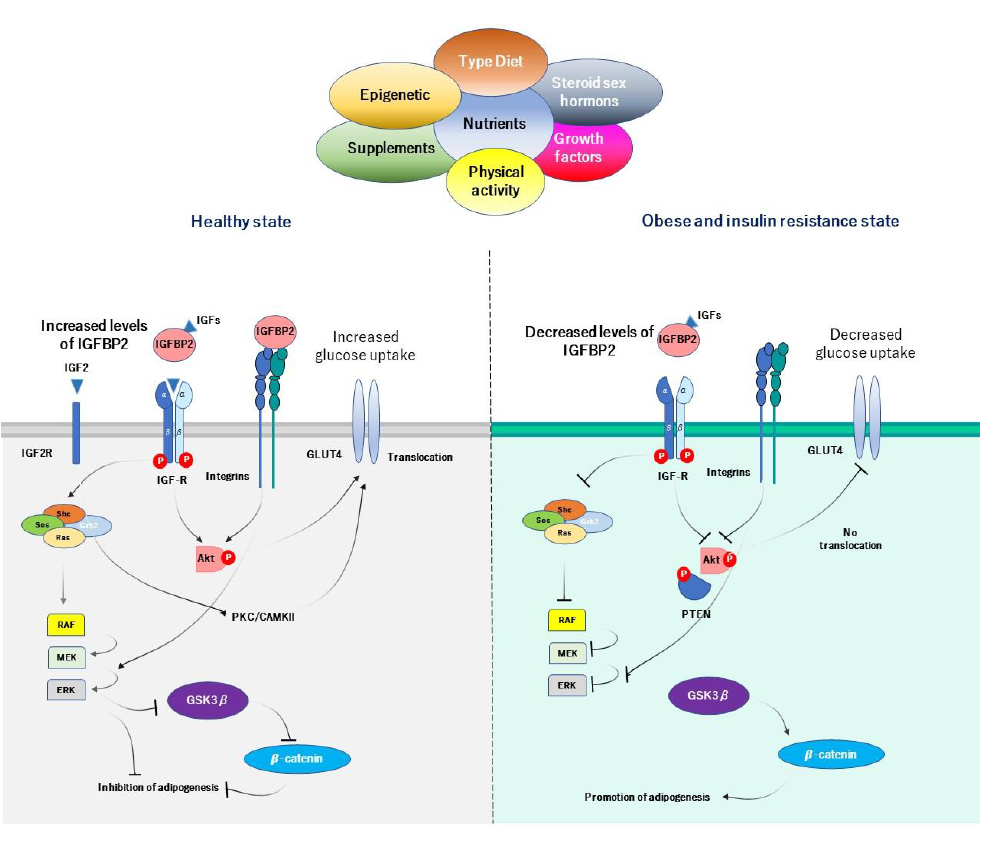
Figure 3. Proposed mechanism of action of IGFBP2 in obesity and insulin sensitivity. Dietary components and lifestyle modifications could affect circulating levels and mRNA expression of IGFBP2 . The combination of these factors could provide a functional role of IGFBP2 on several metabolic disorders, and assign different strategies of prevention. In health state, higher levels of IGFBP2 act in both dependent and independent models to inhibit adipogenesis and activate the translocation of GLUT4, and improve the insulin sensitivity. In obese and insulin resistant state, lower IGFBP2 levels are the results of multiple factors, such as diet, sedentary, and low component and supplement from diet. When IGFBP2 is decreased, the adipogenesis process is activated and the translocation of GLUT4 is reduced, which results in increased body fat and poor insulin sensitivity.